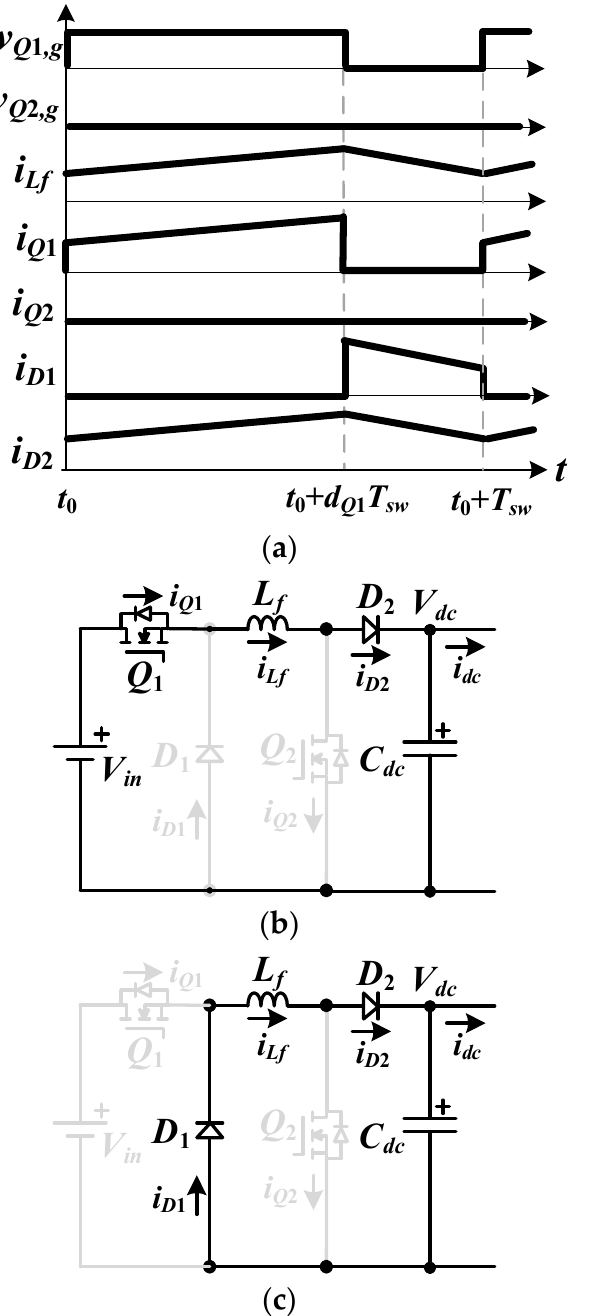
Figure 4. Buck/boost converter under high voltage range (buck operation) ( a ) PWM signals ( b ) mode 1 equivalent circuit ( c ) mode 2 equivalent circuit.